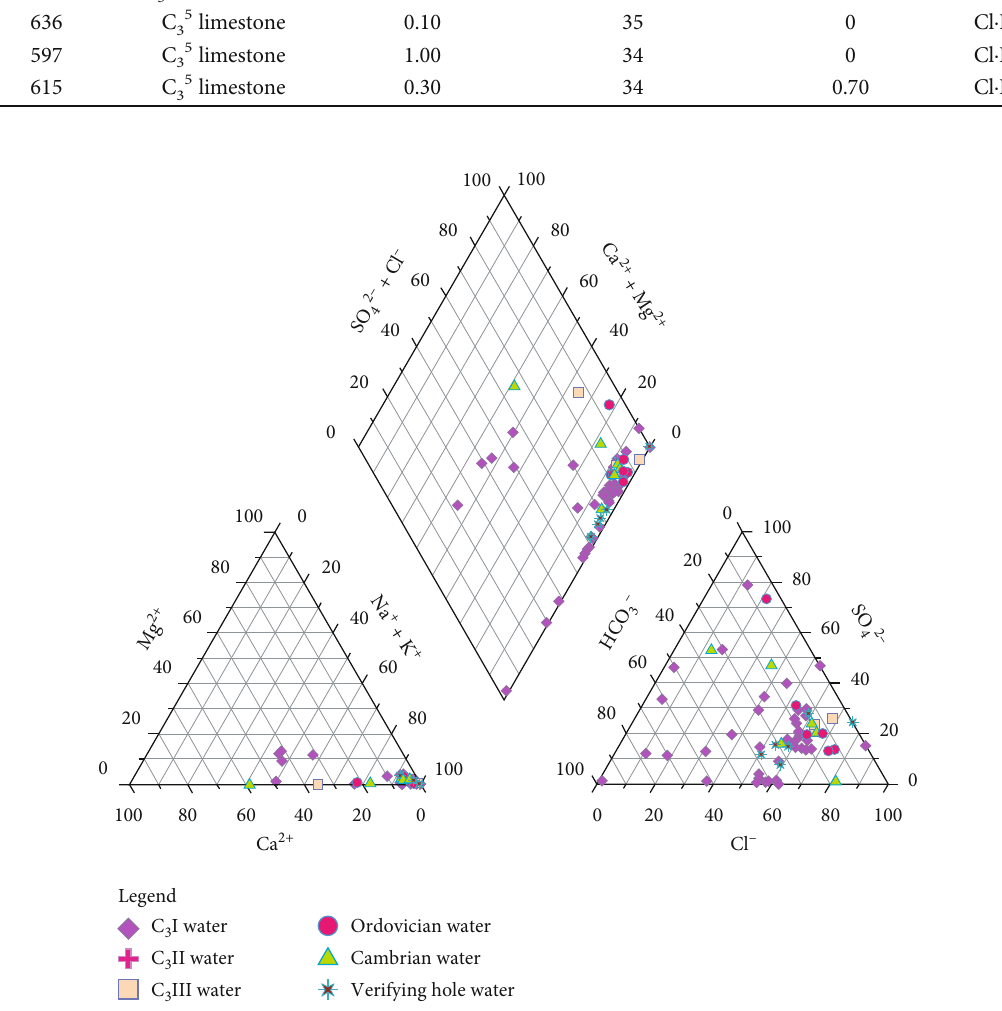
I, C II, and C III groups), 3 3 3